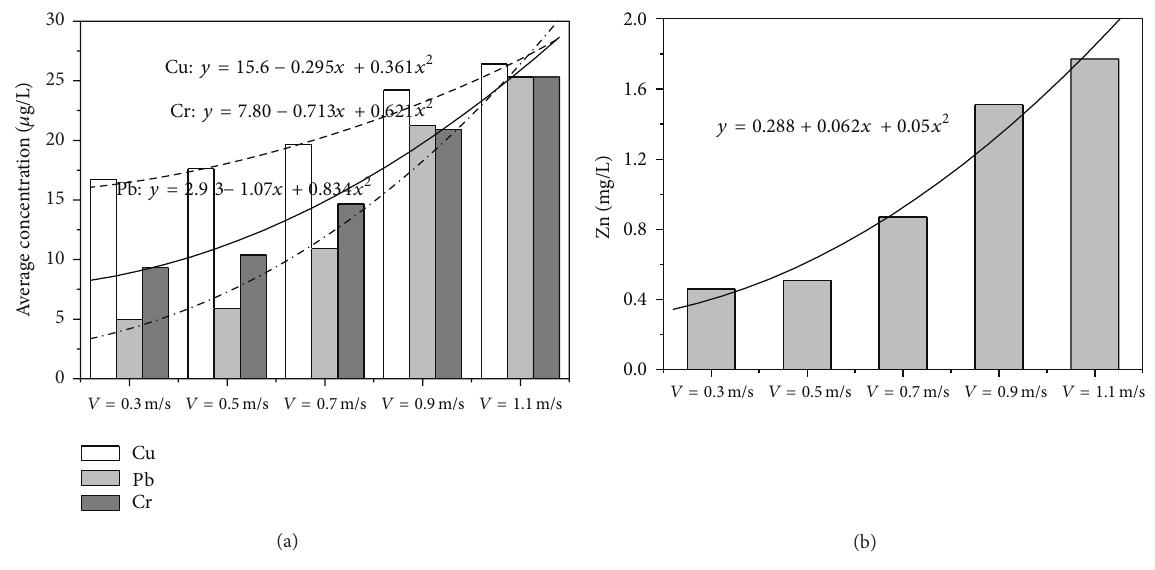
Figure 10: The relationship between the average concentration of metals in overlying water in experimental period and flow rates: (a) Cu, Cr, and Pb; (b)